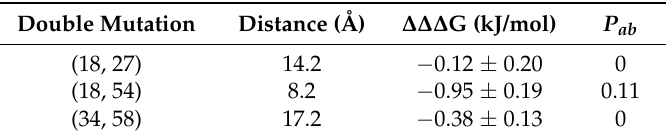
Table 3. P ab for double-site mutations for Eglin c protein. The simulation is based on wild type Eglin c (PDB code 1EGL [17]), and the distance is measured between the two mutation sites. Double